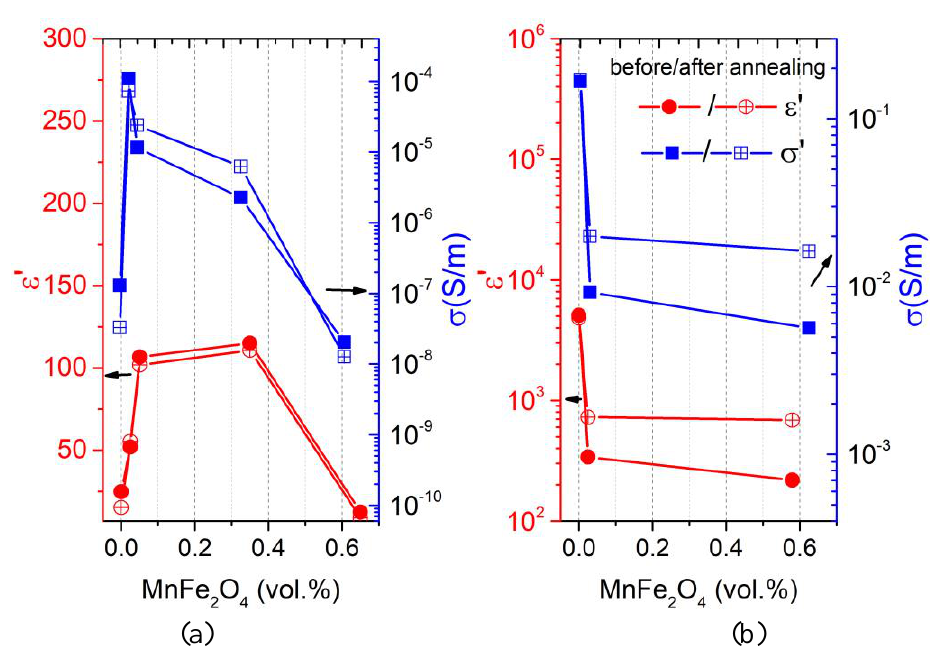
Figure 4. MnFe 2 O 4 -concentration dependencies of the real part of dielectric permittivity and electrical conductivity for composites with ( a ) 0.09 vol.% and ( b ) 0.58 vol.% of MWCNTs at room temperature and 129 Hz before and after annealing at 500 K.